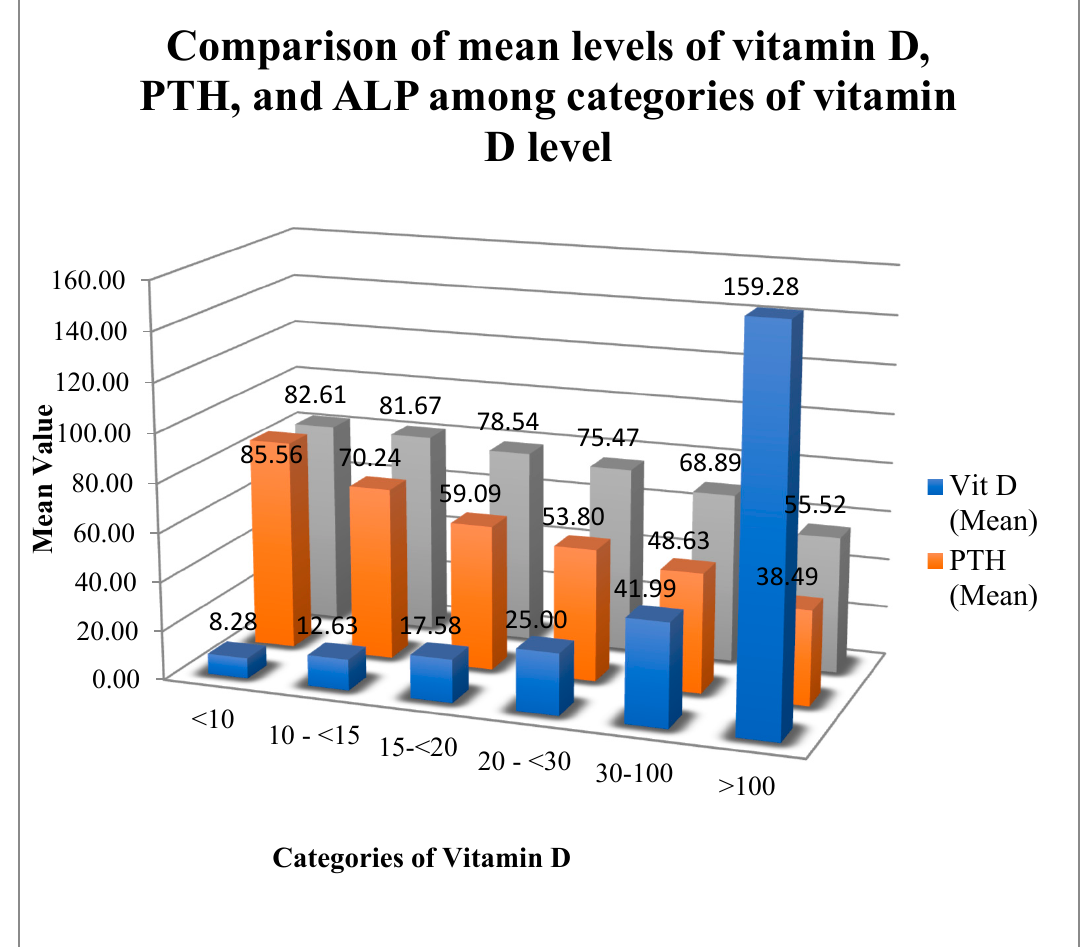
Figure 7. Comparison of mean levels of vitamin D, PTH, and ALP between categories of vitamin D level .